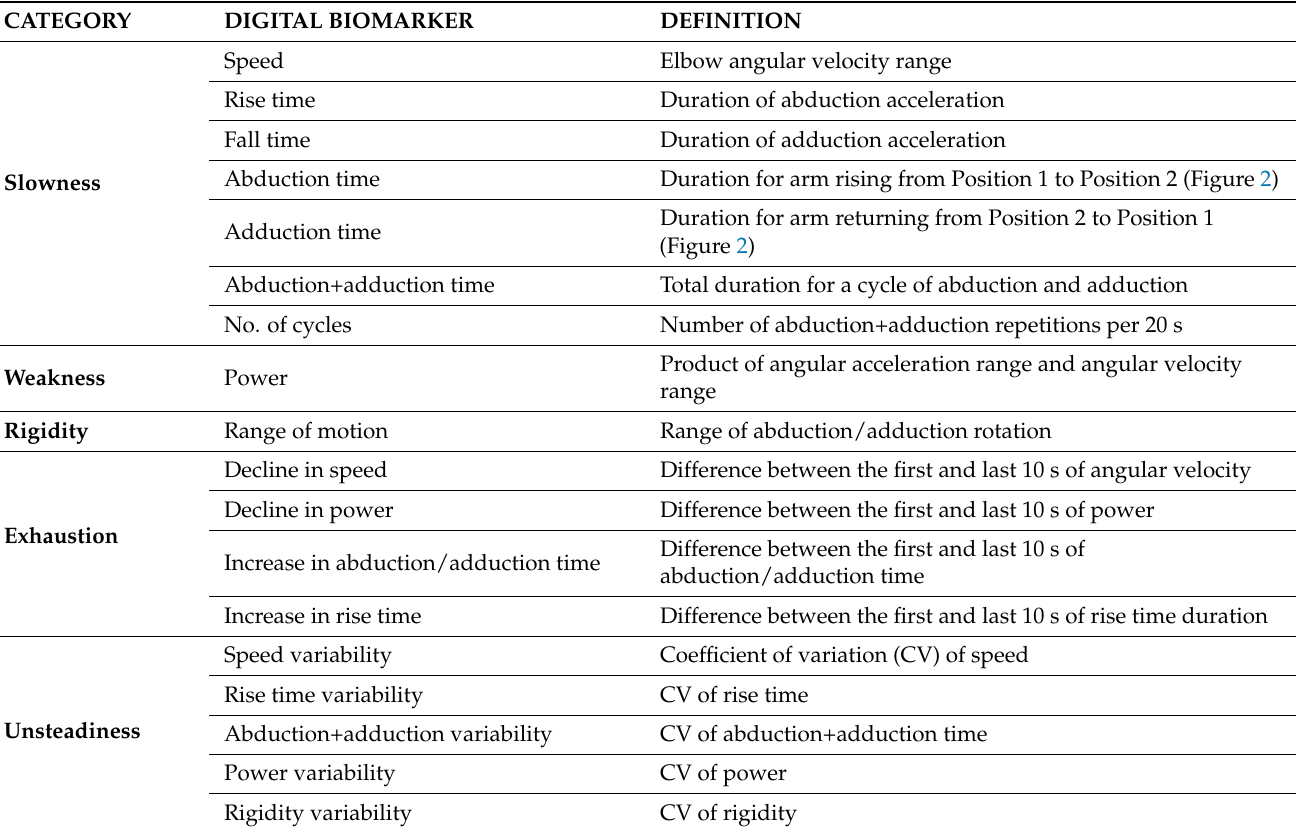
Table 2. Sensor-derived digital biomarkers of upper extremity motor capacity.